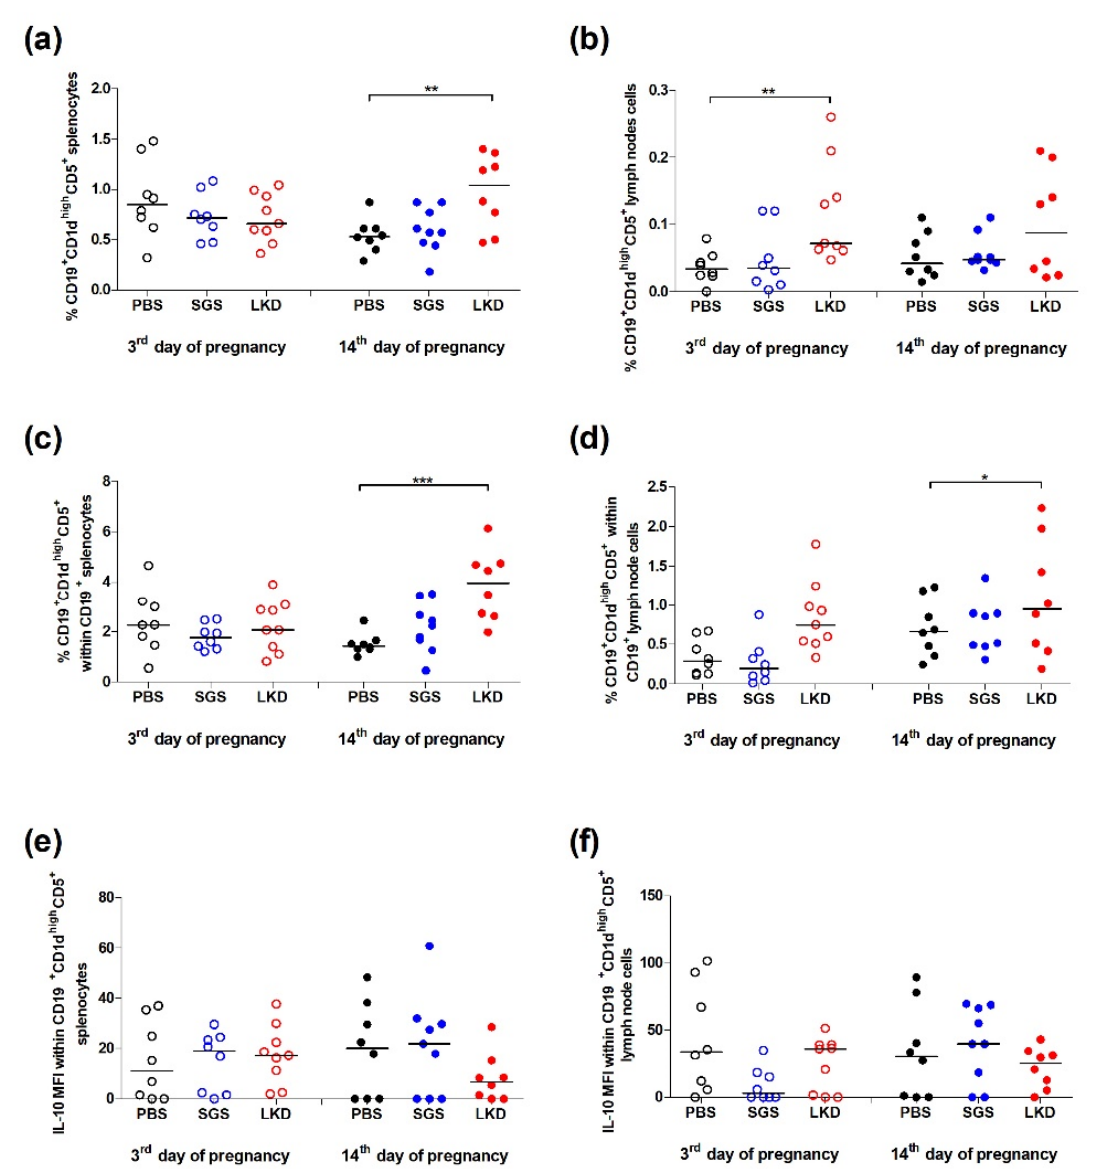
Figure 5. Effect of SGS and LKD on the proportions of CD19 + CD1d + CD5 + ( a ) splenocytes and ( b ) uterine-draining lymph node cells in the ( c ) CD19 + splenocytes and ( d ) CD19 + uterine-draining lymph nodes, respectively, and the production of IL-10 by the CD19 + CD1d + CD5 + ( e ) splenocytes and ( f ) lymph node cells at 3 dpc and 14 dpc in abortion-prone mice. Data were analyzed using one-way analysis of variance (for normally distributed data), followed by Bonferroni’s multiple comparison post hoc test or the Kruskal–Wallis test (for non-normal distributed data), followed by Dunn’s multiple comparison post hoc test ( p < 0.05). Data are presented as individual values with the median. * p < 0.05, ** p < 0.01, and *** p < 0.001.